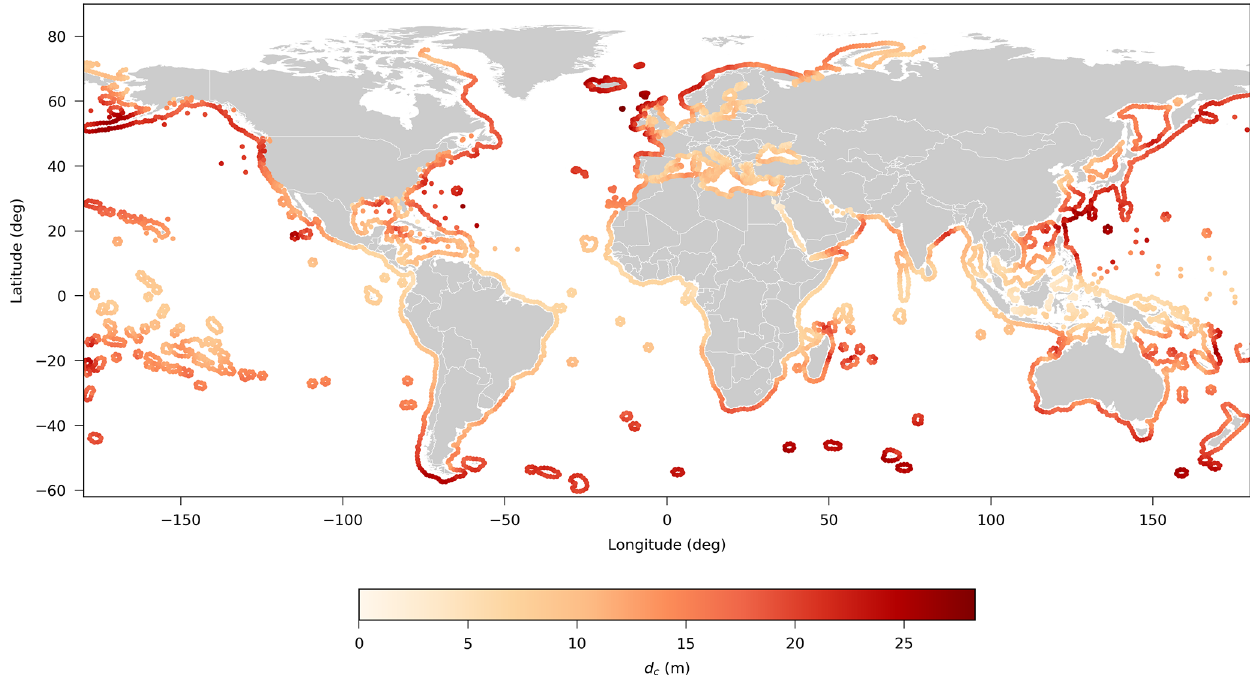
Figure 2. Depths of closure d c along the global coastline using the formulation by Nicholls et al. (1998) (Eq. 1).